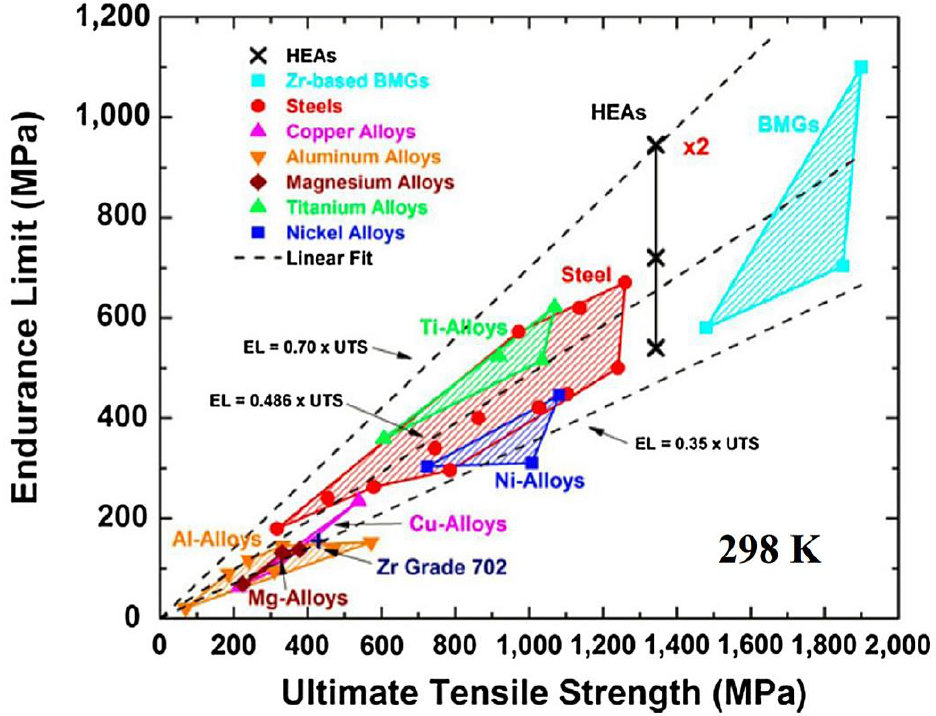
Figure 3. Endurance limits of the Al 0.5 CoCrCuFeNi HEA as a function of the ultimate tensile strength, compared with other structural materials and bulk metallic glasses (BMGs) (reproduced from Reference [68] with permission).